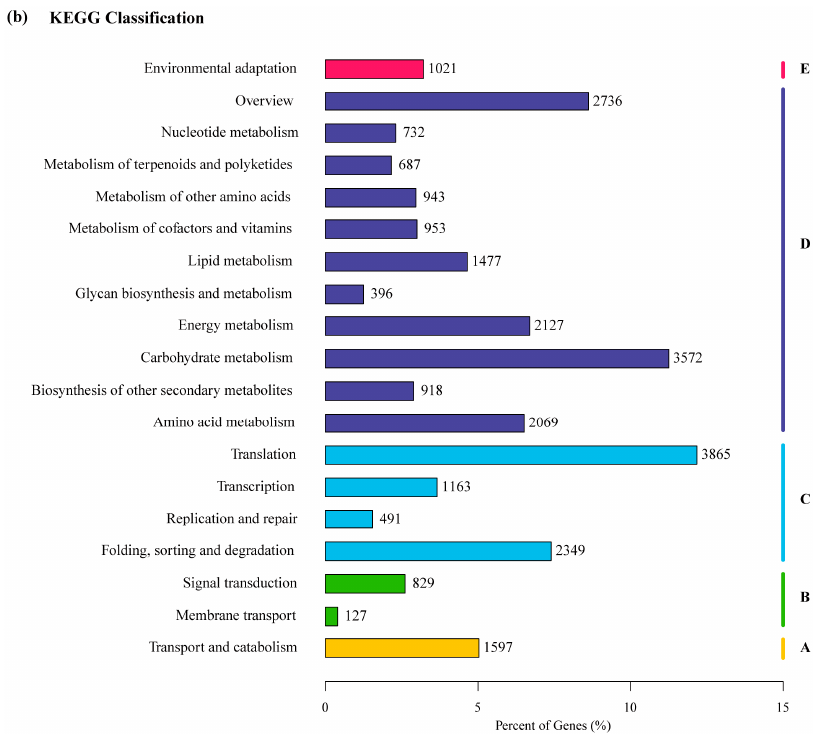
Figure 1. Transcriptome annotation of Eucommia ulmoides leaves. ( a ) Gene Ontology (GO) annotation of non-redundant consensus sequences of Eucommia ulmoides . Most consensus sequences against GO database were grouped into three major functional categories i.e., biological process (BP), cellular component (CC), and molecular function (MF); ( b ) Pathway assignment of Eucommia ulmoides unigenes based on the Kyoto Encyclopedia of Genes and Genomes (KEGG) database. ( A ) Cellular process categories; ( B ) environmental information processing categories; ( C ) genetic information processing categories; ( D ) metabolism categories; and ( E ) organismal systems categories.